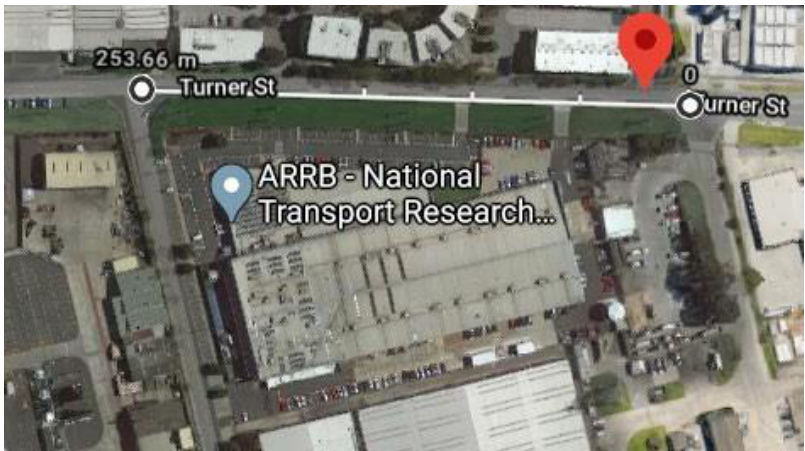
Figure 2. Turner Street drone capture area, Source (https://www.google.com/maps (accessed on 26 October 2020)).